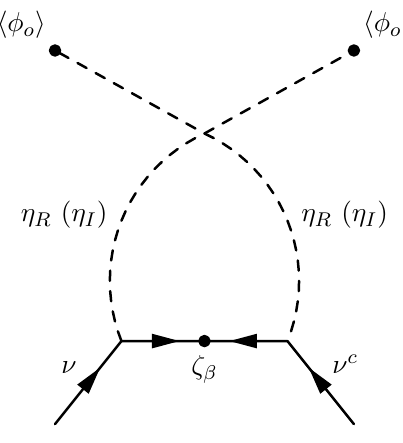
Figure 1 . Radiative contributions for neutrino masses in the STSM. Notice that there are two contributions, one from (cid:17) R and other one from (cid:17) I